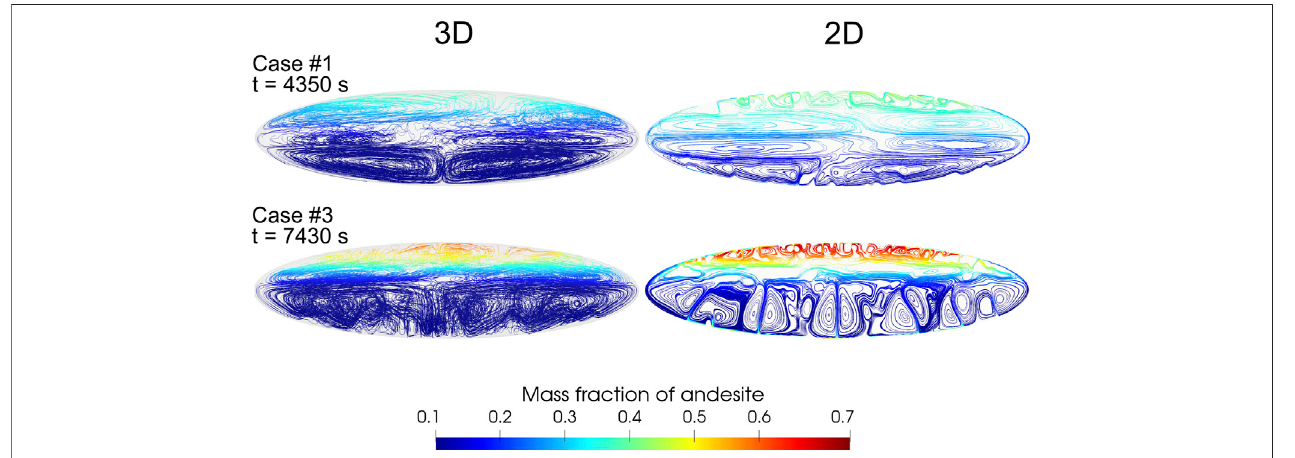
FIGURE 6 | Streamline structure with composition colorbar.